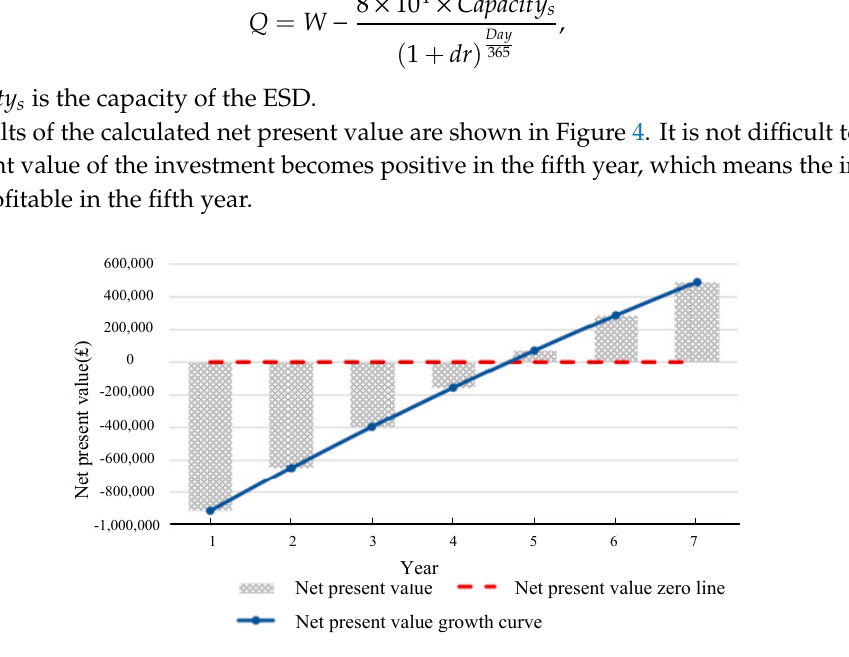
Figure 5. Return on investment curve under dynamic analysis. According to Figure 5, as the time increases, the net present value of the investment continues to increase until it reaches the initial investment present value on the 1708th day, i.e., 4.6795 years, which is the payback period. In other words, the owner of the ESD will begin to make profits on September of the fourth year. By the end of the seventh year, which is the end of the life cycle of the ESD, the total profit was £1,689,100, which is 1.4076 times the original investment. The discount rate is assumed to be 5.6% in the above calculation. However, the actual discount rate varies with time and region, so it is necessary to introduce the internal rate of return to increase the accuracy. The net present value is calculated in the model, hence, the investment value can be determined further through the supplementary analysis of the internal rate of return (IRR) to help potential ESD investors to make investment predictions. The value of the internal rate of return is the value of the discount rate when the payback period is exactly reached. The calculation formula is as follows: when 0 IRR dr